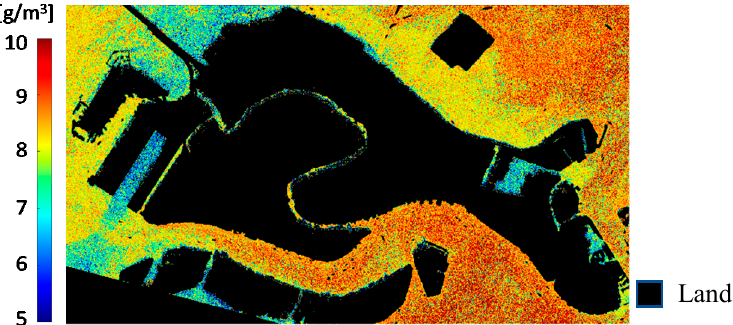
Figure 4. Concentration of TSM during the extreme flooding in the Venice lagoon (26 November 2019).